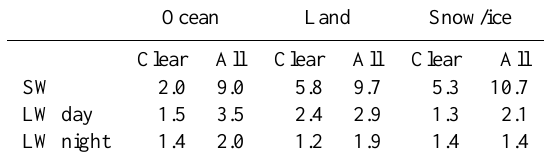
Table 5. TOA instantaneous footprint-level flux uncertainties (Wm − 2 ) for SW flux, daytime and nighttime LW flux under clear- sky and all-sky conditions over three surface types based upon CERES MODIS flux consistency test.